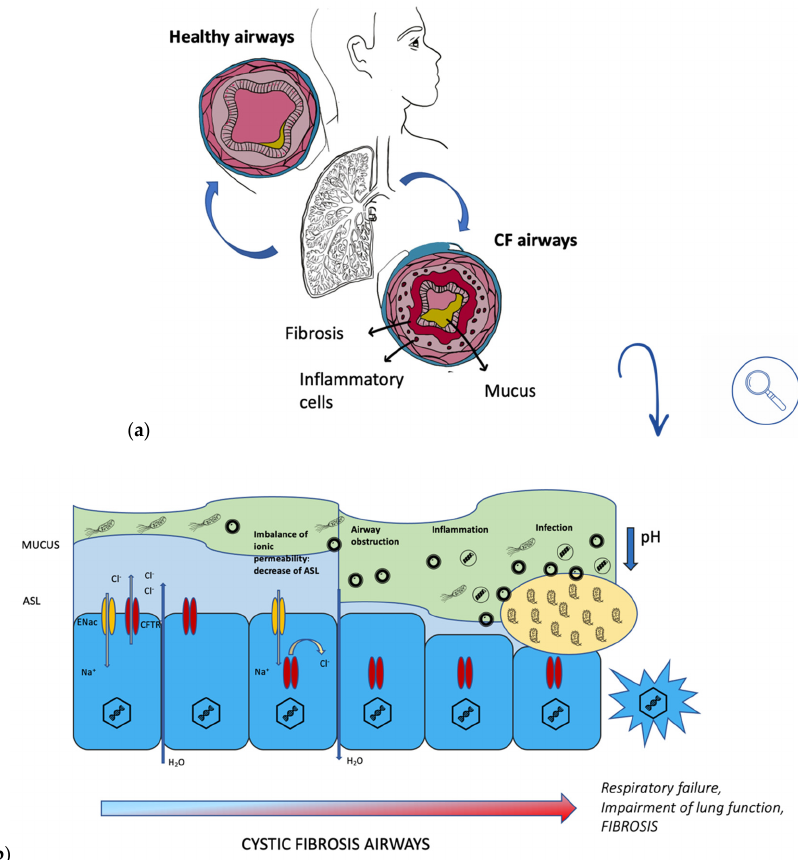
Figure 2. ( a ) comparison between healthy airways and CF airways; ( b ) progression of CF in airways.